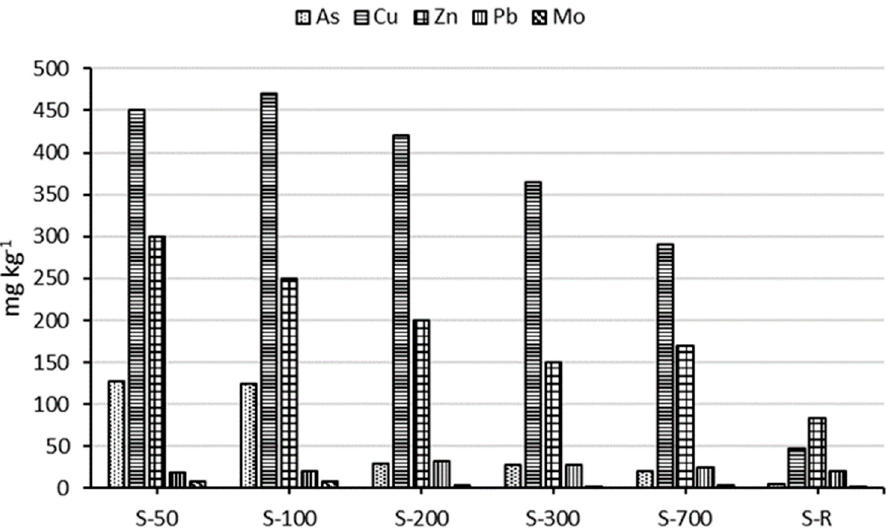
Figure 2. Concentrations of some HMs in the soil located at different distances from the Alaverdi copper smelter.